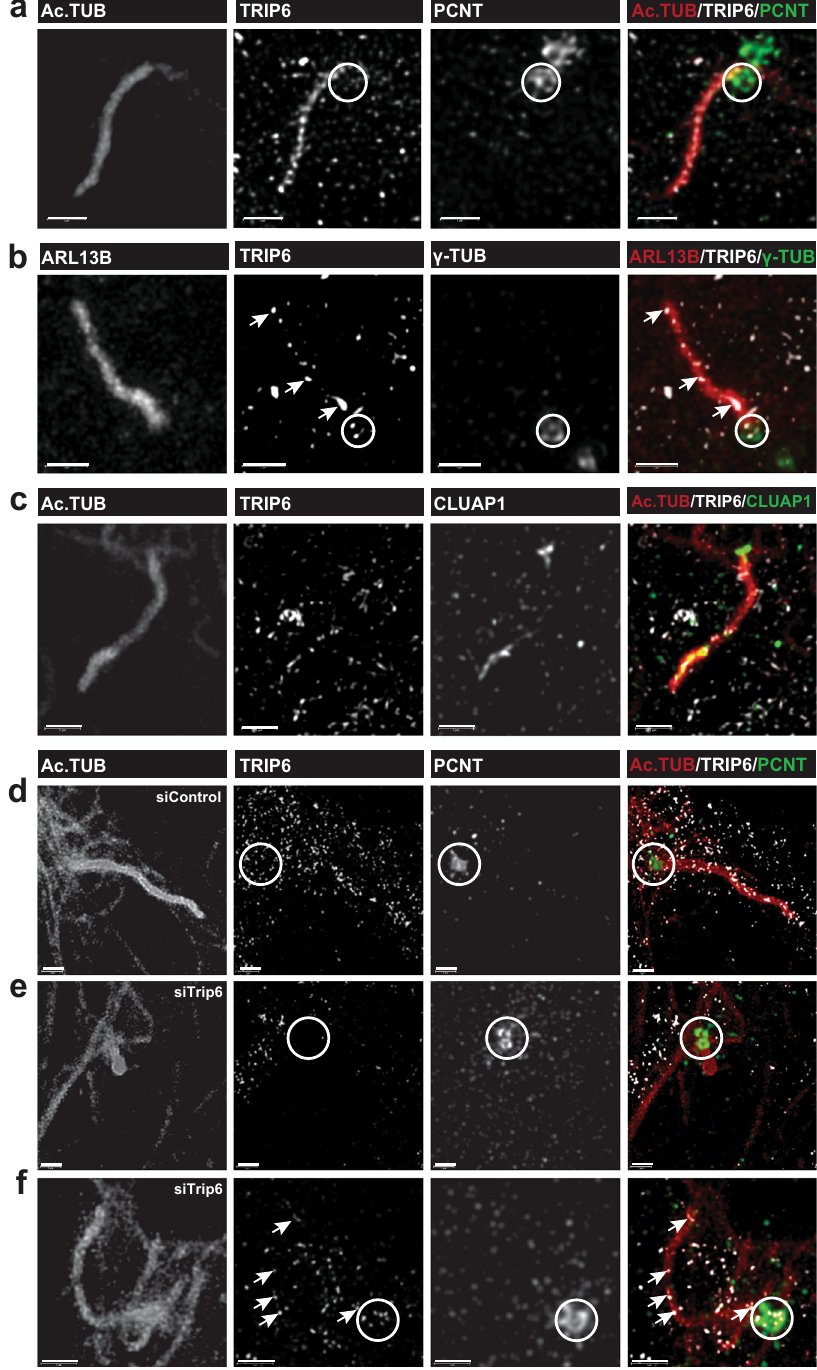
Fig. 9 Localization of TRIP6 in primary cilia of choroid plexus-derived Z310 cells, via super resolution microscopy. Representative examples of six primary cilia, labeled with the structural cilia components acetylated α -tubulin (Ac.TUB), ARL13B or CLUAP, and with anti-TRIP6. TRIP6 localized in foci along the axoneme, exhibiting variable distribution among individual cilia (arrows in b , f ) when compared to the more uniform sub-ciliary localization of Ac.TUB and ARL13B ( a , b ). Super resolution identi fi es two major axonemal sites of CLUAP ( c ). Additionally, TRIP6 partially co-localized with the basal body markers pericentrin (PCNT; a , d ) and γ -tubulin ( γ -TUB; b ). Basal bodies are indicated by circles. Downregulation of trip6 expression, by siRNA, reduced the length of the axoneme without affecting the basal body ( e cf . d ). Nevertheless, those cells presenting with elongated cilia, in the siTrip6-treated cultures (partial downregulation), were found to still express TRIP6 that localized along the axoneme (arrows, f ) and in the basal body (circle, f ). Scale bars: 1 μ